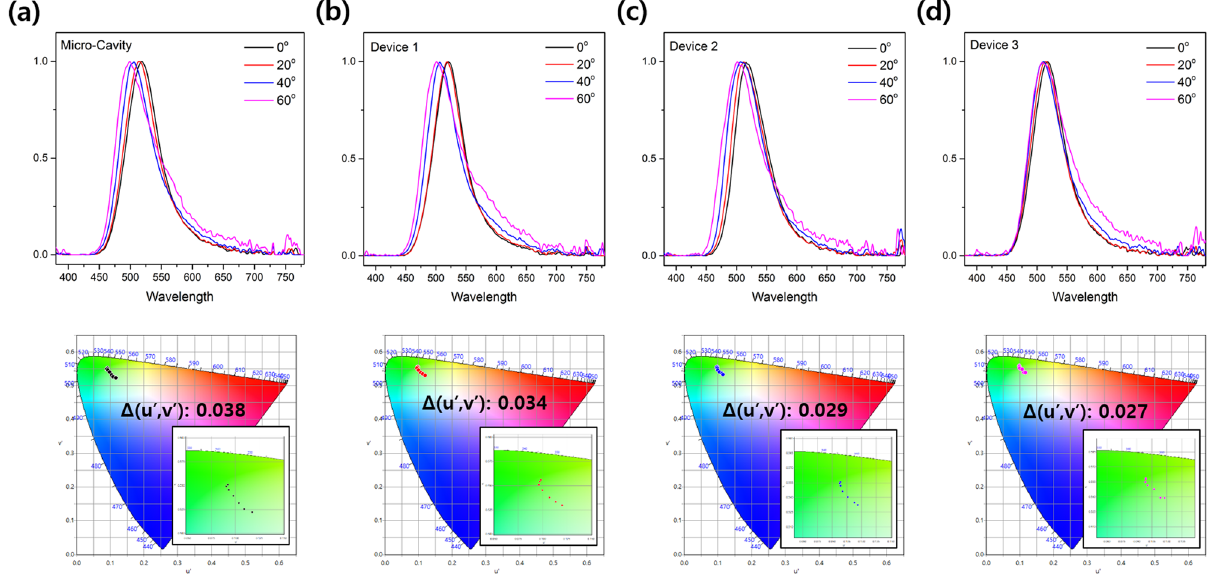
Figure 6. Viewing angle characteristics of the OLEDs with different diffusion layers (above: EL spectra, below: color coordinate according to viewing angle): ( a ) Micro-Cavity device, ( b ) Device 1, ( c ) Device 2, and ( d ) Device